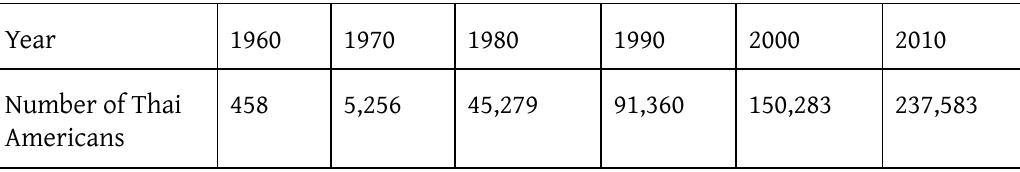
Table 1 Thai American Population in the United States